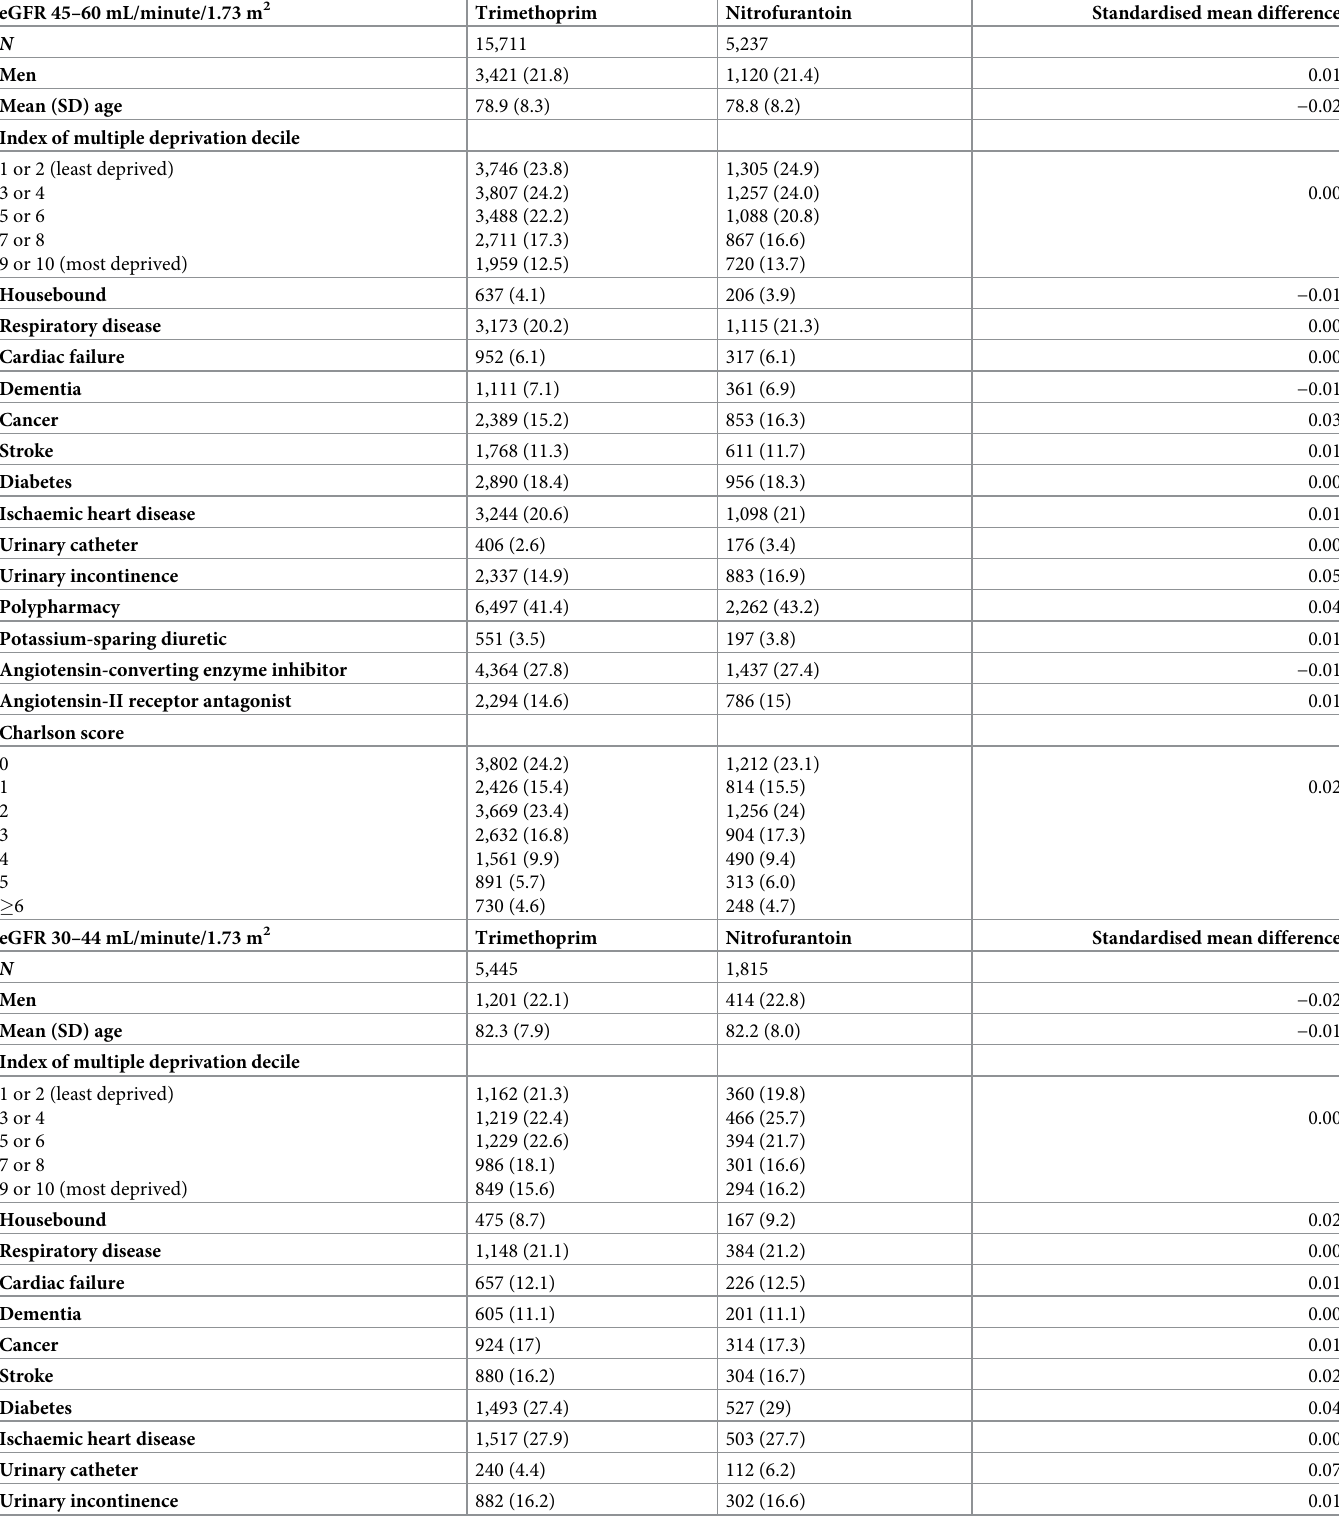
Table 3. Balance of baseline characteristics across trimethoprim and nitrofurantoin groups following propensity score matching for patients with renal